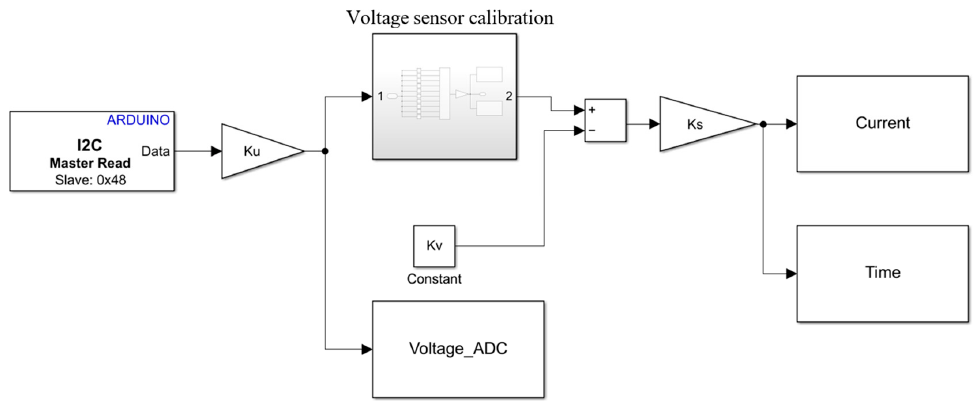
Figure 17. Motor wheel module data acquisition scheme and Matlab Simulink connection for the 16-bit ADC.